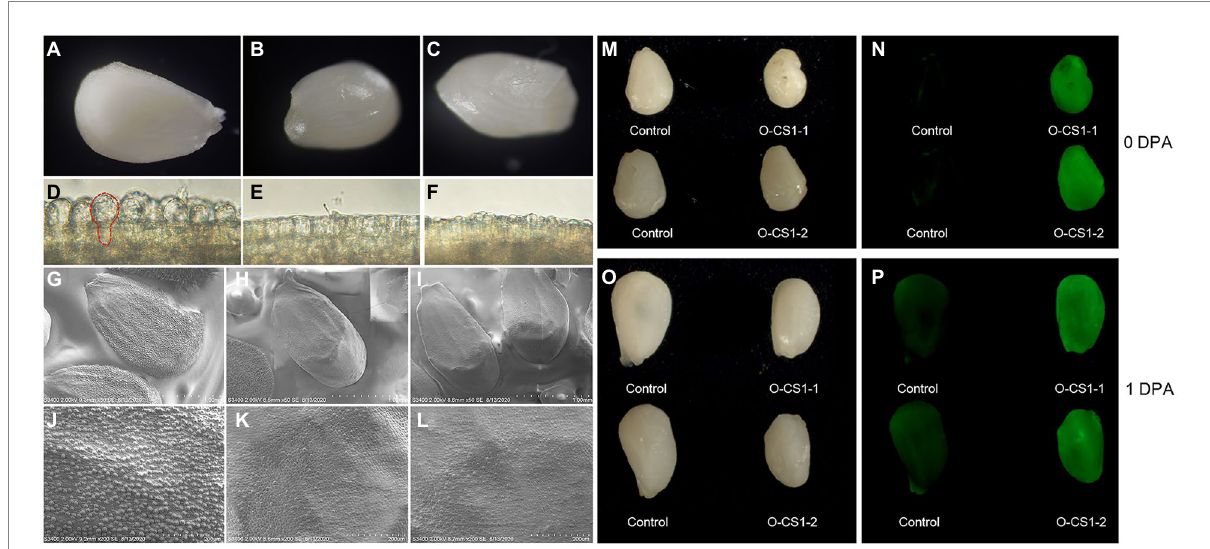
FIGURE 5 The fiber cell initiation and ROS accumulation in 0-DPA and 1-DPA ovules. (A–C) The entire surface of the control and transgenic lines O-CS1-1, O-CS1-2 0-DPA ovules, respectively; (D–F) respectively an enlarged area of the ovule shown in (A–C) ; (G–L) The 0-DPA ovule of control and transgenic lines O-CS1-1, O-CS1-2 photos taken by SEM, (G–I) are the entire surface of the ovule, and (J–L) are partial enlargements of panels (G–I) , respectively. (M,N) The 0-DPA ovules of control and transgenic plants under light and UV light. (O,P) The 1-DPA ovules of control and transgenic plants under light and UV light. O-CS1-1 and O-CS1-2: Transgenic cotton lines 1# and 2# overexpressing GhCS1.